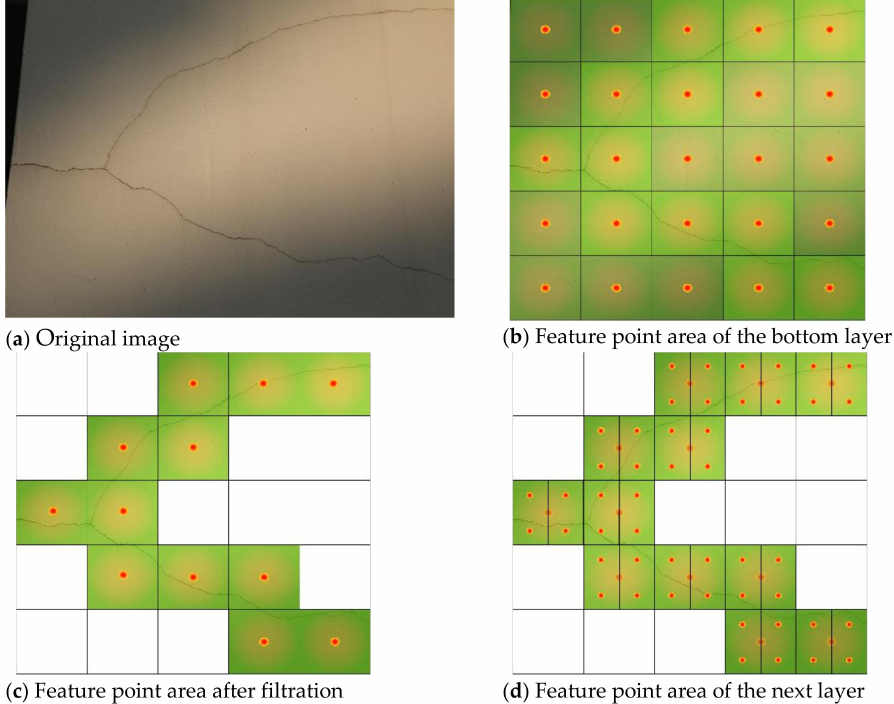
Figure 9. Feature filtration